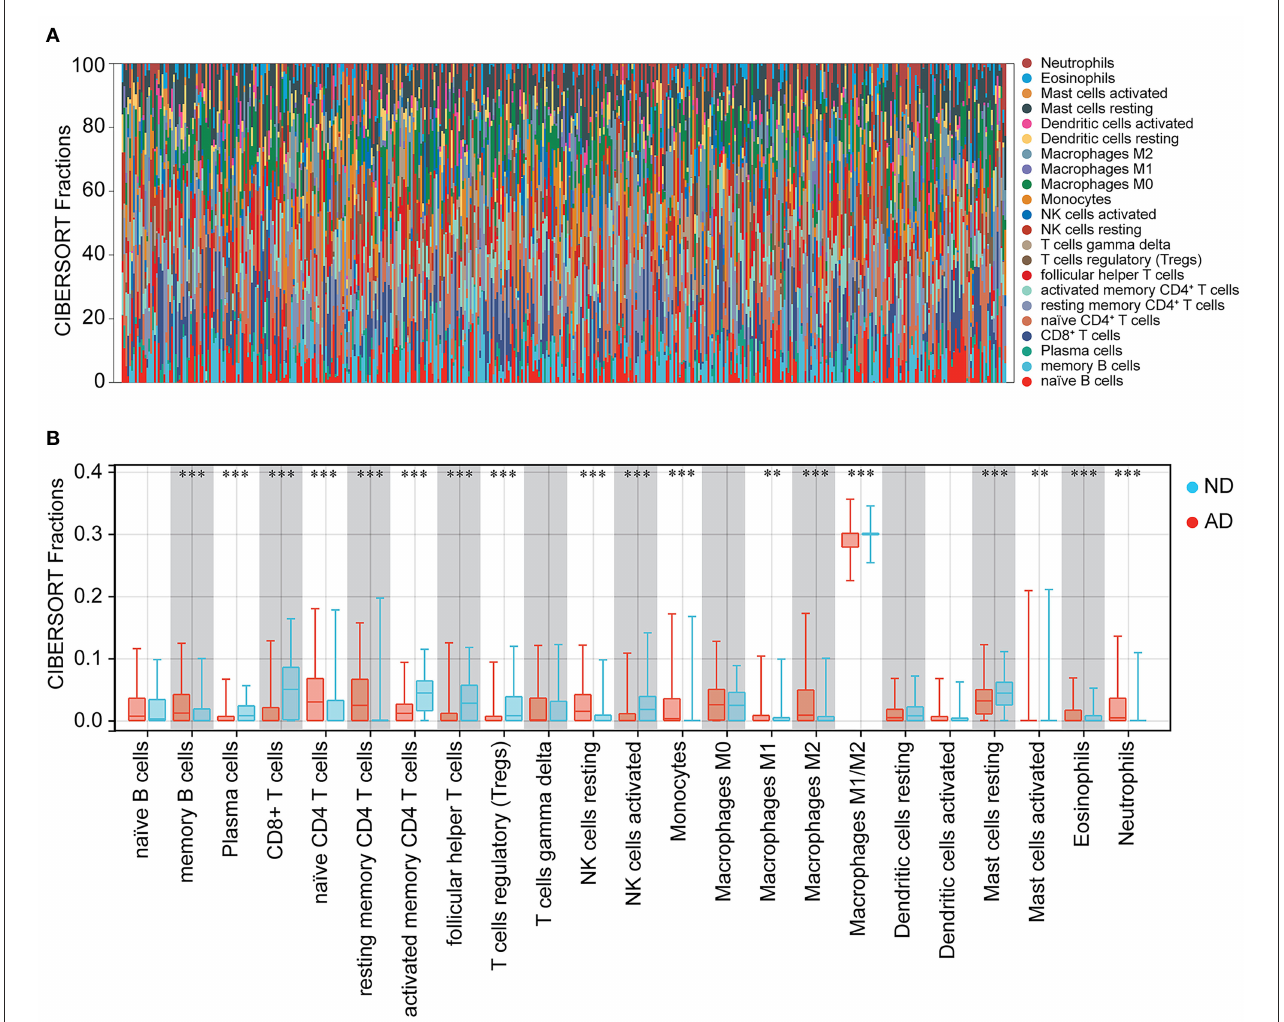
FIGURE8 Immune cell infiltration between ND and AD samples. (A) The percentage of 22 immune cells in each sample. (B) Different levels of immune infiltrating cells between ND and AD